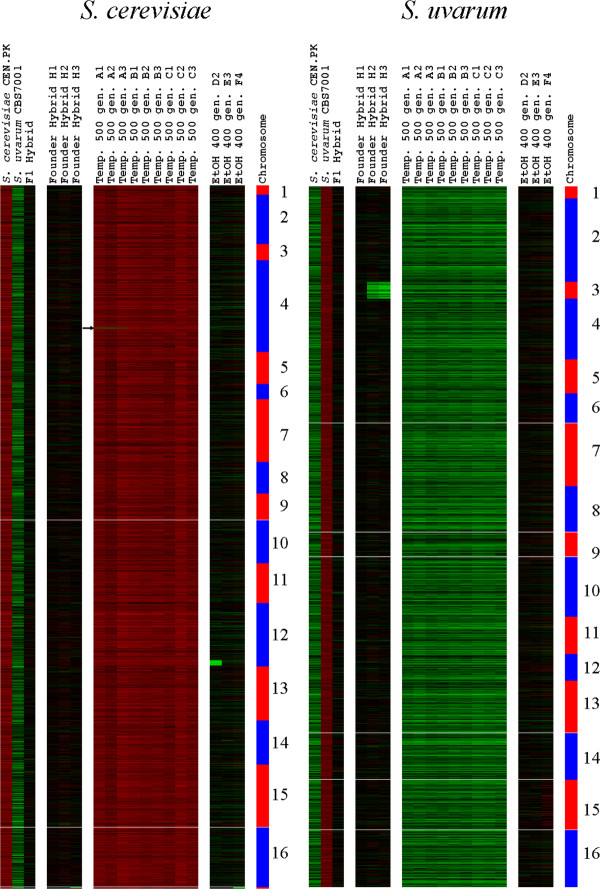
Array-CGH data for parents, F1, representative founders, and temperature-and ethanol-selected clones. Each column contains the a-CGH hybridization data for a given strain, while each row corresponds to a probe for a chromosomal location. Probes are ordered downward (for each parental genome separately as shown at top) from the left end of Chromosome I (top-most probe) to the right end of Chromosome XVI (bottom probe); note that probes for the S. cerevisiae mitochondrion are shown below its Chromosome XVI. Strains that show most of their hybridization intensities as a red color indicate the presence of most or all of the "red" parental species' genome, concomitant with the absence (green) of all or most of the other species' genome, whereas hybridization intensities appearing as black indicate a balanced complement of both parental species' genomes. The arrow indicated a deletion is located on Chromosome IV and corresponds to the ARS in the region between HXT6 and HXT7.